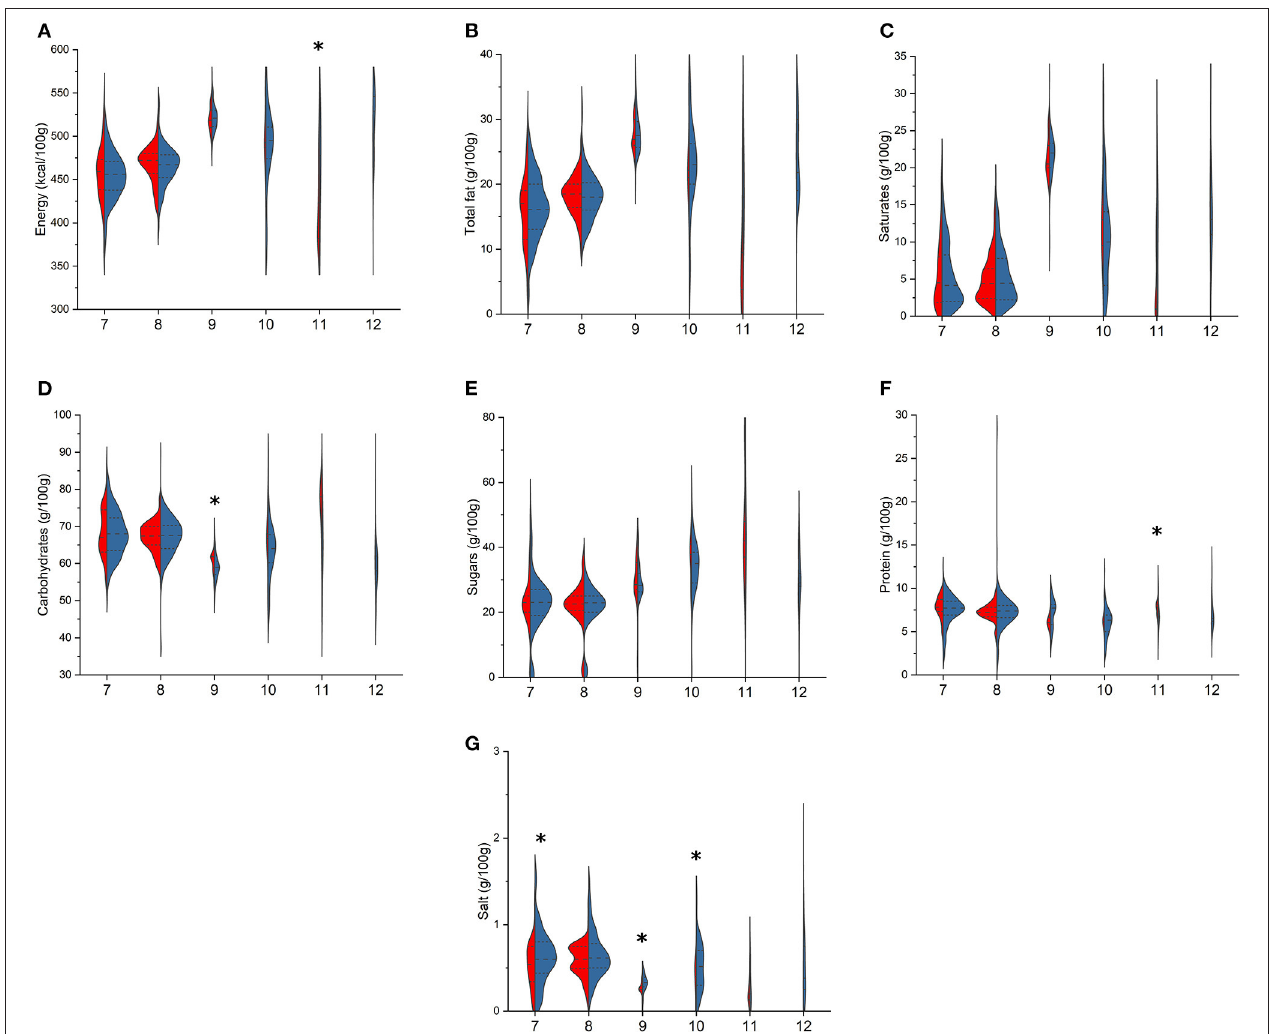
FIGURE 2 | Comparison of energy (A) , total fat (B) , saturates (C) , total carbohydrates (D) , sugars (E) , protein (F) , and salt (G) content in branded (BR, in blue) and private-label (PL, in red) types of biscuits. 7: tea cookies; 8: shortbread biscuits; 9: cream-filled wafer; 10: covered and/or sandwich cookies; 11: Italian traditional biscuits; 12: other biscuits. For each type, asterisk indicates significant difference between BR and PL items (Mann–Whitney non-parametric test for two independent samples), p <